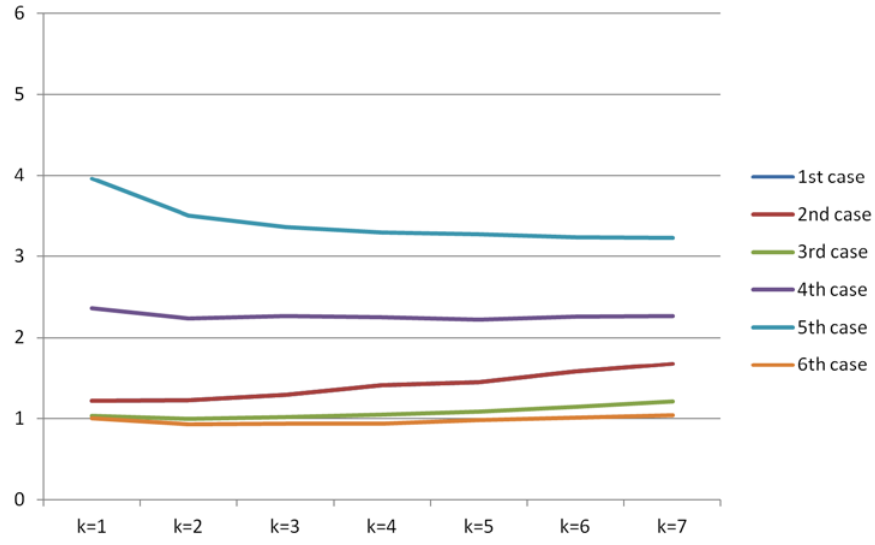
Figure 9. MAPE [%] for different cases of kNN method utilization (Table 1, Table 3, Table 7, Table 9, and Table 11).